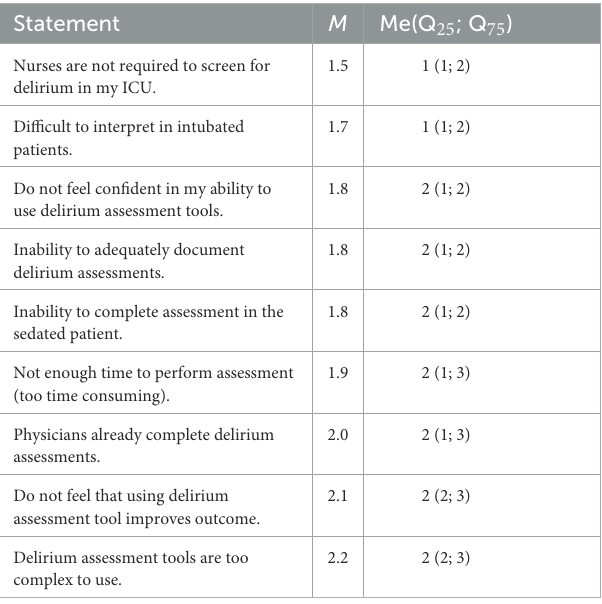
TABLE 4 Barriers to effective nurses’ control of delirium.